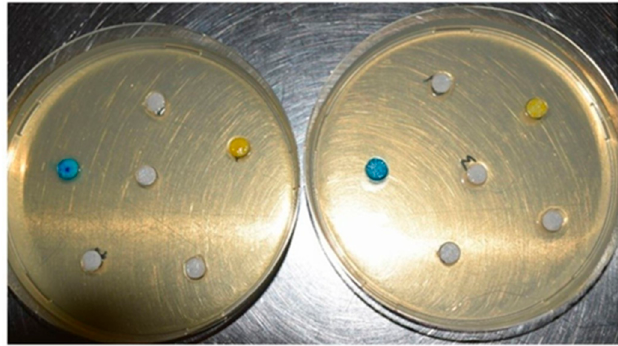
Figure 1. Application of various types of gels on sterile disks (left = E. coli ; right = S. aureus ). The size of these areas of inhibition actually indicates how we quantify antimicrobial activity.